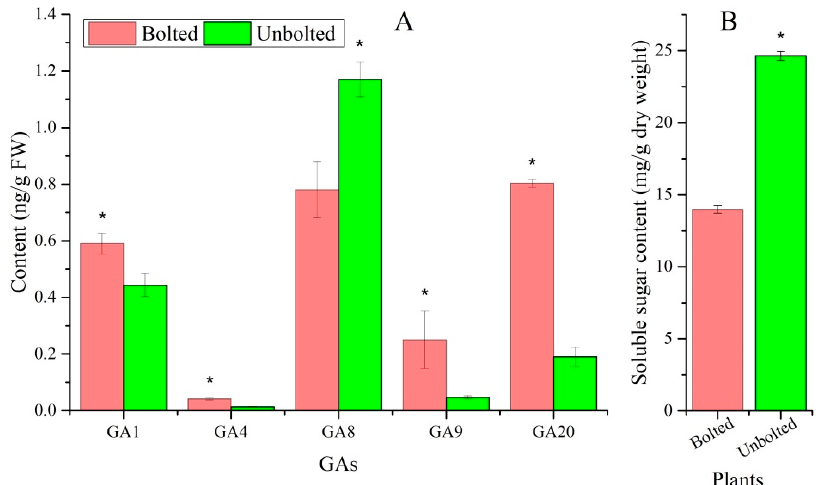
Figure 4. The contents of GAs ( A ) and soluble sugar ( B ) in bolted and unbolted plants, as